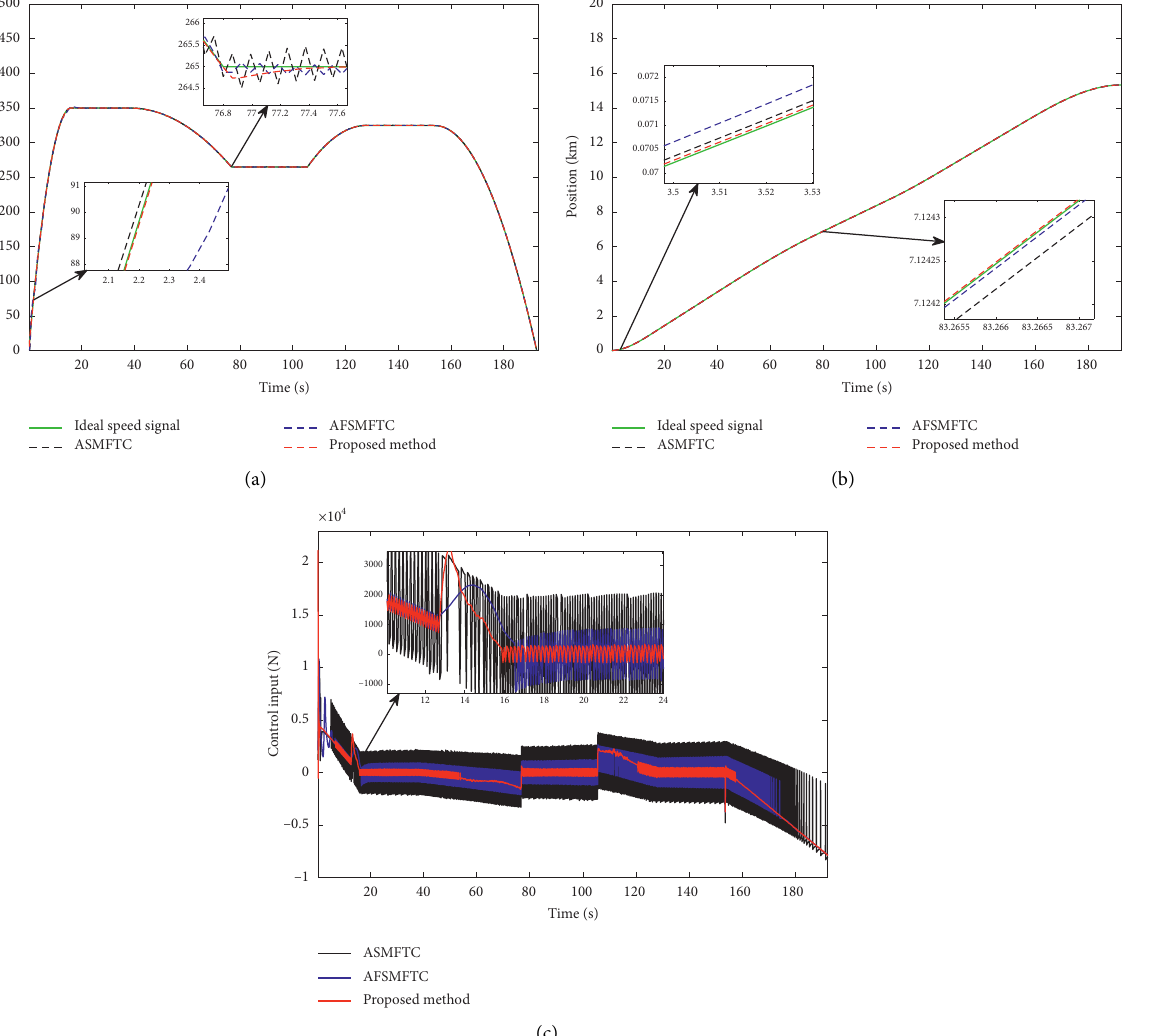
Figure 4: The control effect of the first train using different fault-tolerant control methods. (a) The speed tracking results. (b) The position tracking results. (c) The unit control force input